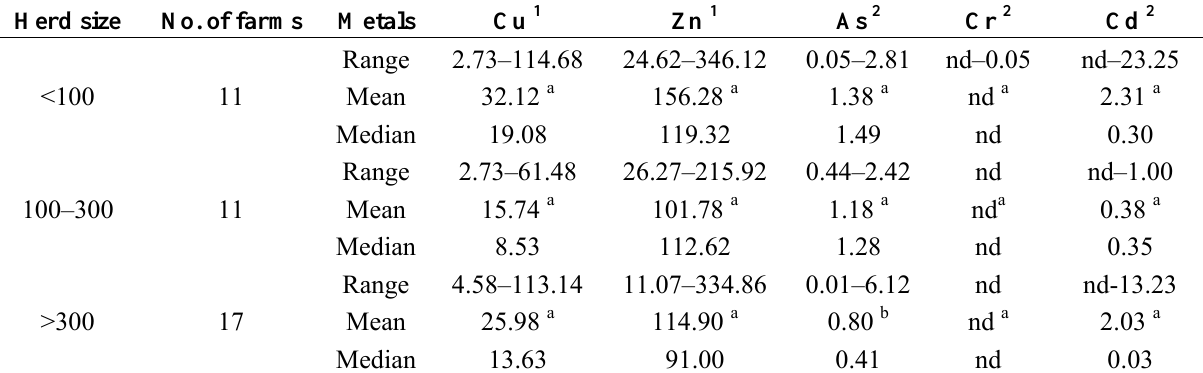
Table 2. Heavy metals in cattle feed from farms of different herd size (mg/kg dm).